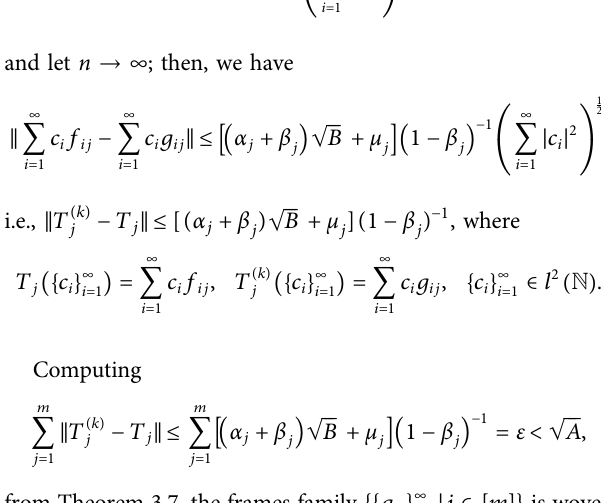
from Theorem 3.7, the frames family {{ g ij } ∞ for H with the universal lower and upper bounds ( (cid:10)(cid:10) √ + ε ) 2 and ( B